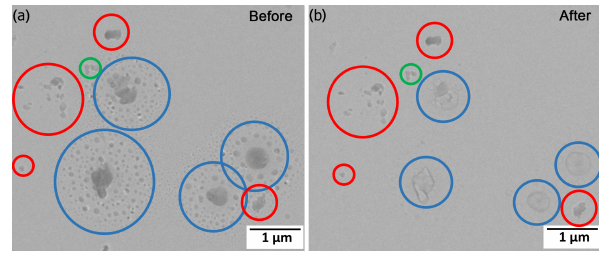
Figure 1. TEM bright-field image of a typical sample (sample I; 17.3km altitude), before (a) and after evaporation (b) . Particles evaporating under electron bombardment are marked with blue cir- cles. They consist of sulfates/hydrogen sulfates. Red circles indicate stable carbonaceous particles. Green circles show refractory car- bonaceous particle internally mixed with volatile sulfates/hydrogen sulfates.